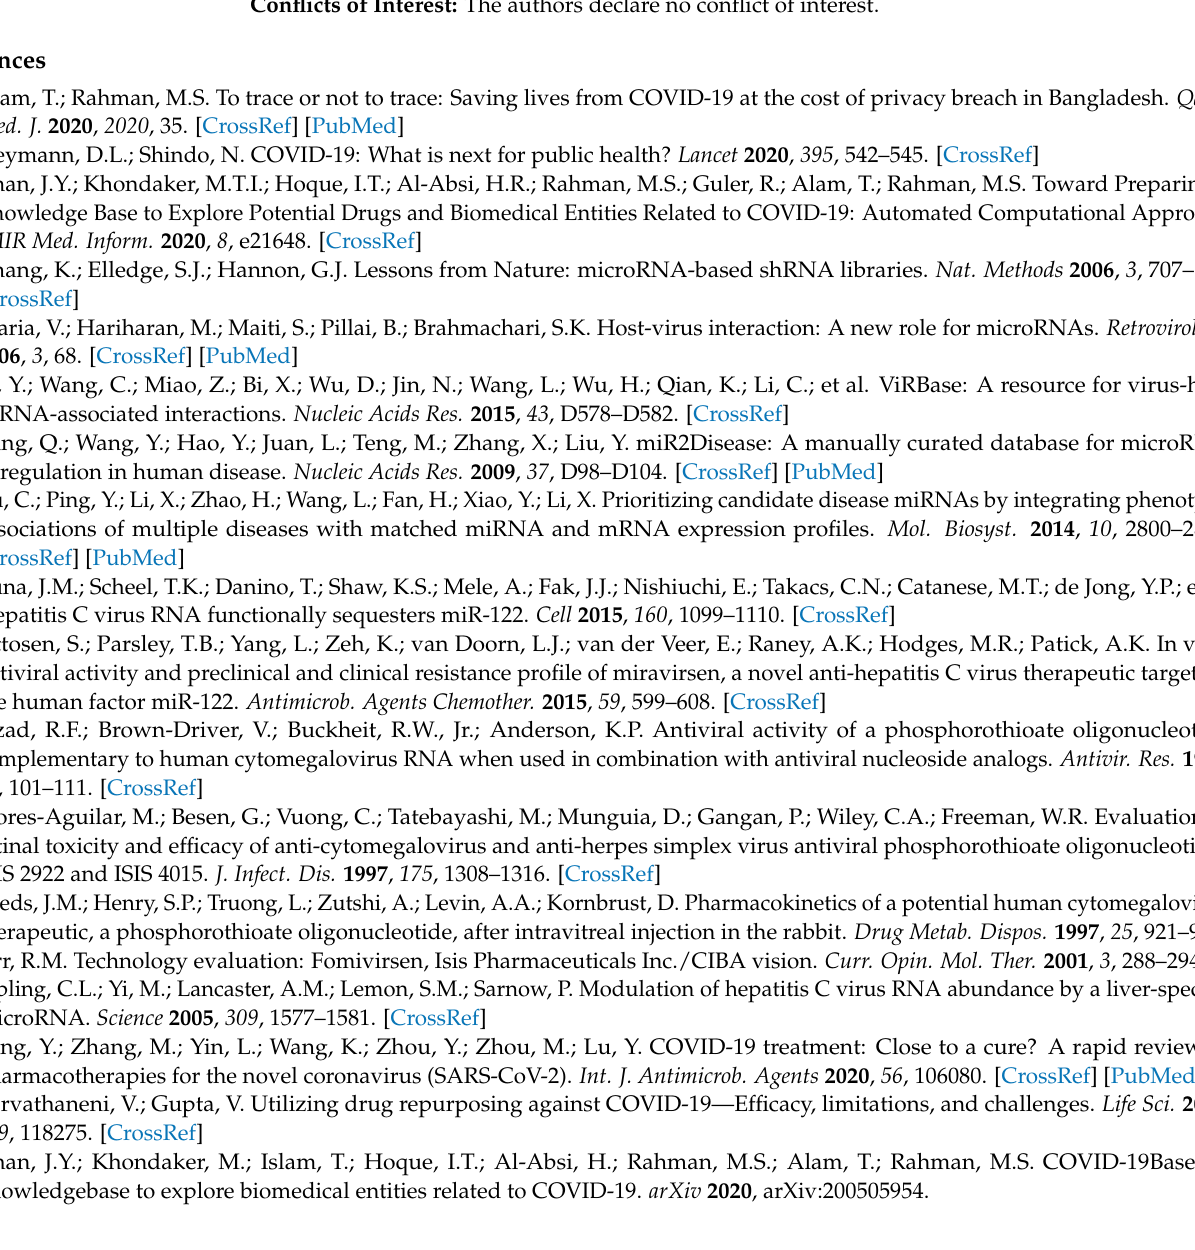
Table S6: Functional analysis (Gene Ontology (GO) term and pathways) of the proposed 14 human miRNAs using miRNet and